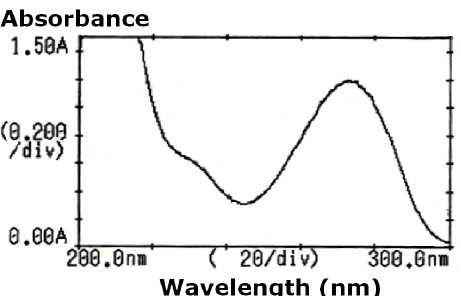
FIGURE 3 - Full UV spectrum of pure caffeine.